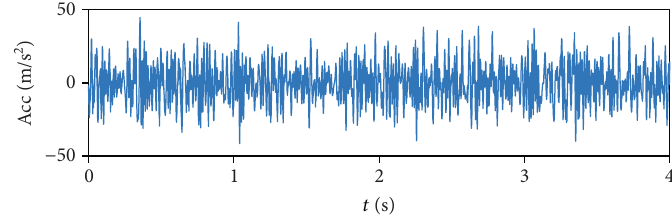
Figure 6: Base excitation signal of the folding fi